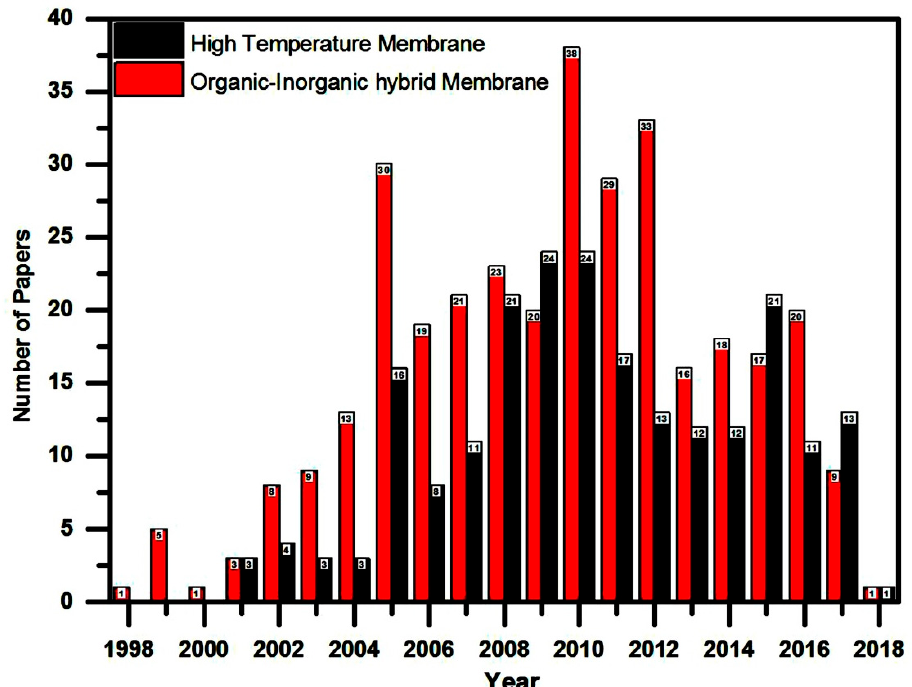
Figure 3. Bar chart illustration of the number of papers published per year 1998–2018 analyzed by Scopus database .